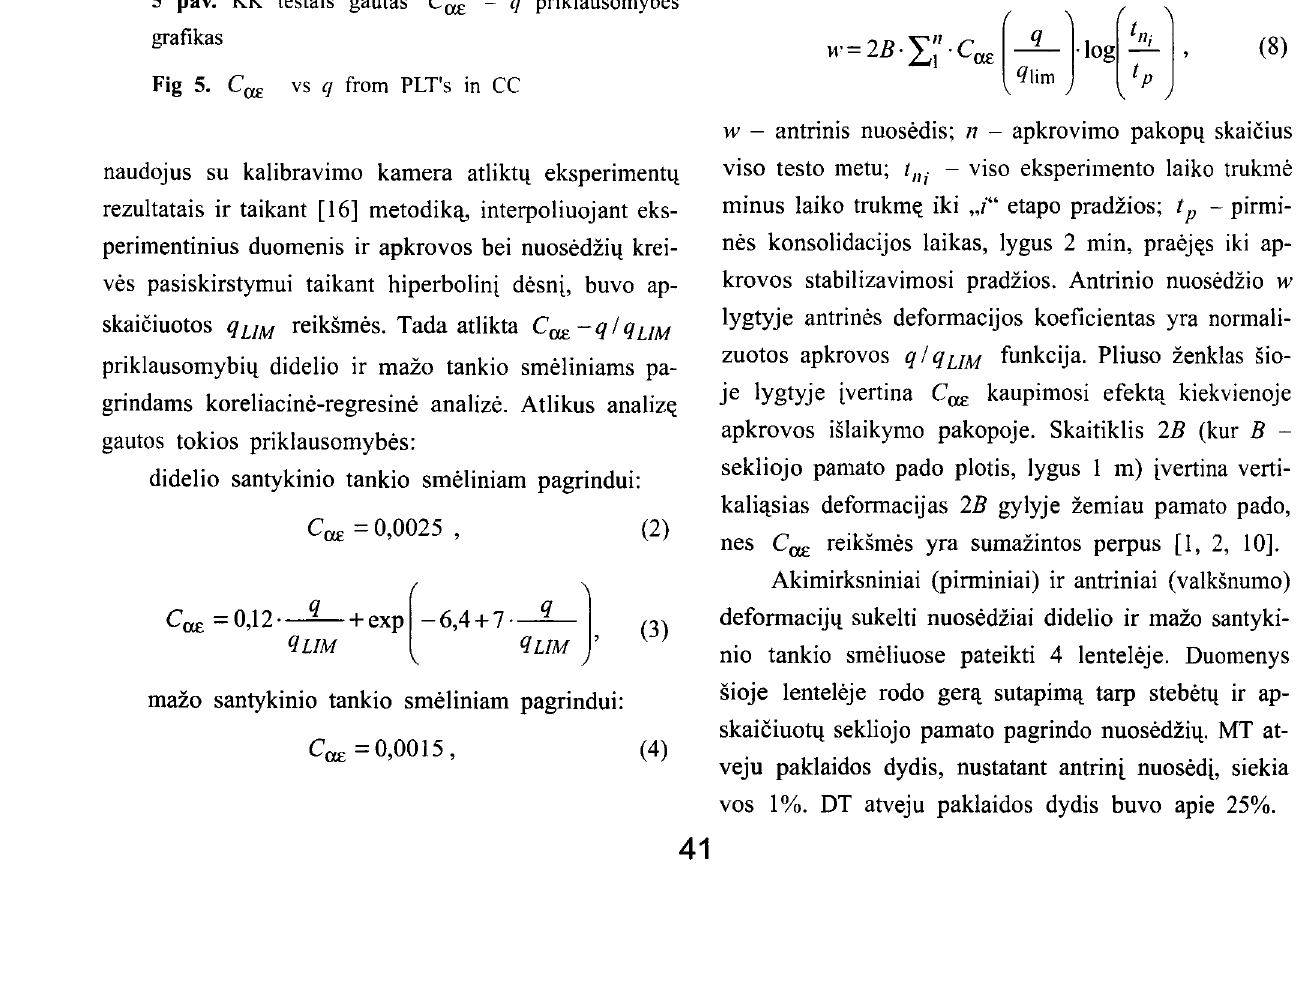
Fig 5. Cru: vs q from PLT's in CC